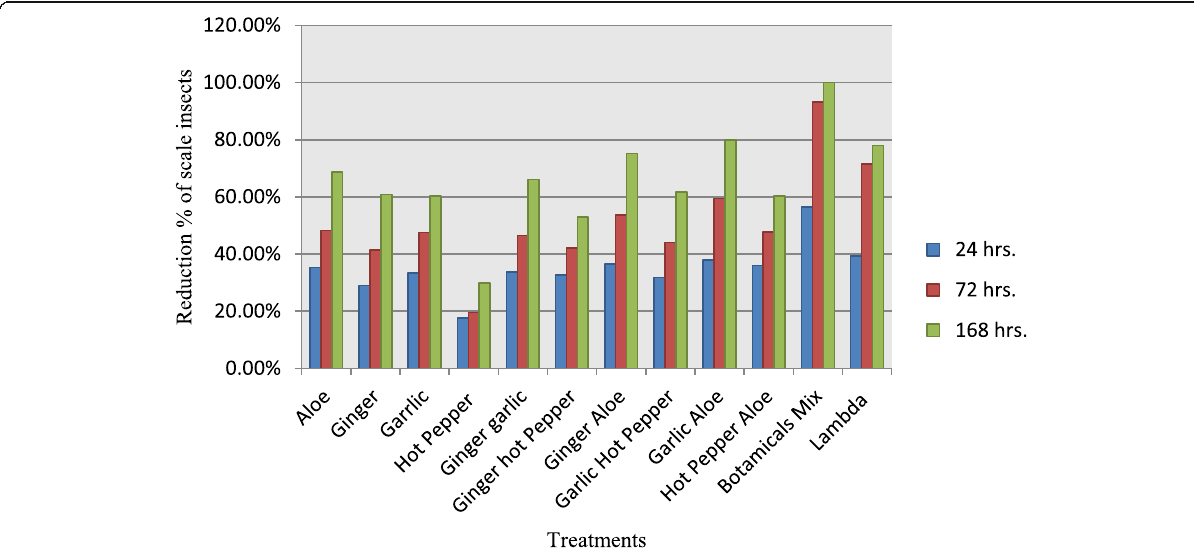
Fig. 1 Reduction percentage of mango scale insect, Aulacaspis tubercularis , after different treatments by plant extracts in season of 2017